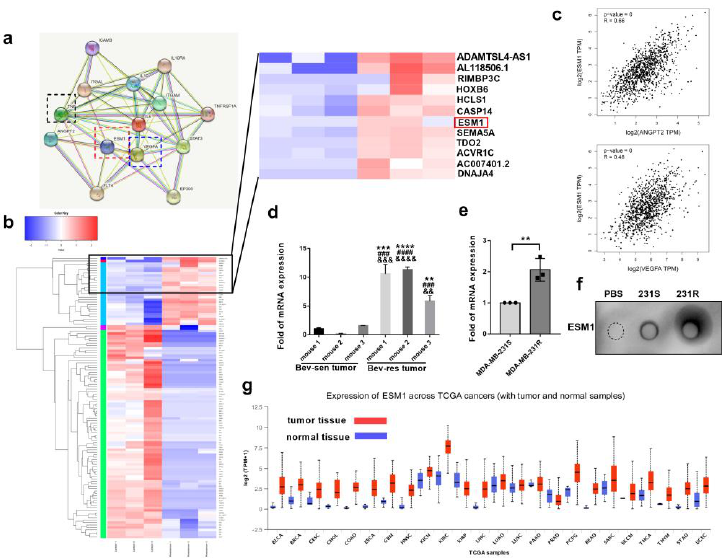
Figure 2. ESM1 is overexpressed in bevacizumab—resistance tumor tissues and cells. ( a ) Protein interaction network between ESM1 and VEGF/ANGPT2/M2b related cytokines in String Database. (Known interactions: light blue line, from curated databases; purple line, experimentally determined. Predicted interactions: green line, gene neighborhood; red line, gene fusions; blue line, gene co—occurrence. Others: yellow line, text mining; black line, co—expression; light purple line, protein homology.) ( b ) Expression pattern clustering heat map of MDA-MB-231-S and 231-R cells. ( c ) Gene correlation of ESM1 with VEGFA or ANGPT2 analyzed by GEPIA Database. ( d ) qRT—PCR of ESM1 mRNA levels in tumor tissues from bevacizumab sensitive and resistant mice. n = 3/group. ** p < 0.01; *** p < 0.001; **** p < 0.0001, by t test. Bev-res vs. mouse1 of Bev-sen group. ### p < 0.001; #### p < 0.0001, by t test. Bev-res vs. mouse 2 of Bev-sen group. && p < 0.01; &&& p < 0.001; &&&& p < 0.0001, by t test. Bev-resistance vs. mouse 3 of Bev-sensitive group. Error bars represent SD. ( e ) qRT-PCR of ESM1 mRNA levels in MDA-MB-231-S and MDA-MB-231-R. n = 3/group. ** p < 0.01, by t test. ( f ) Dot blotting of